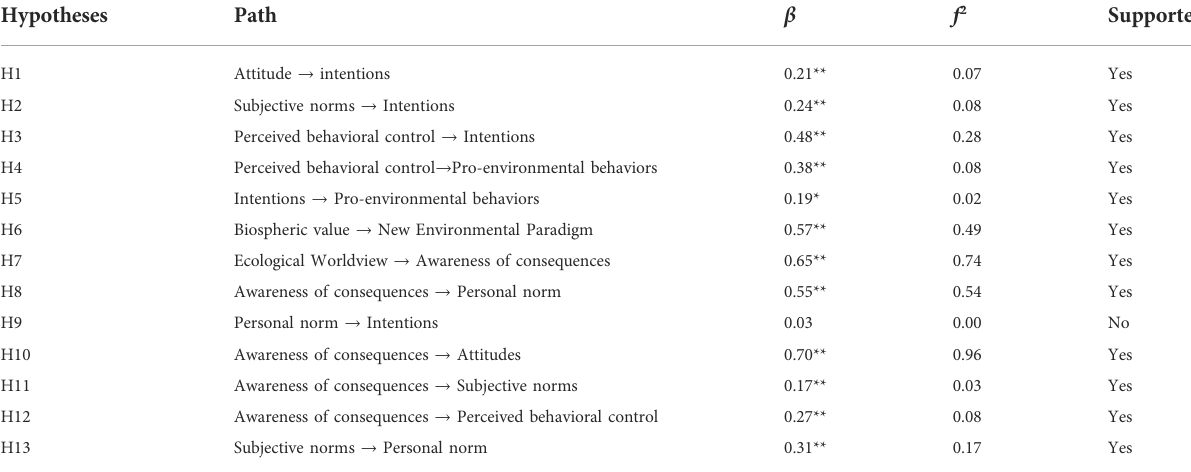
TABLE 4 Standardized path coef fi cients of the structural model and hypotheses testing.